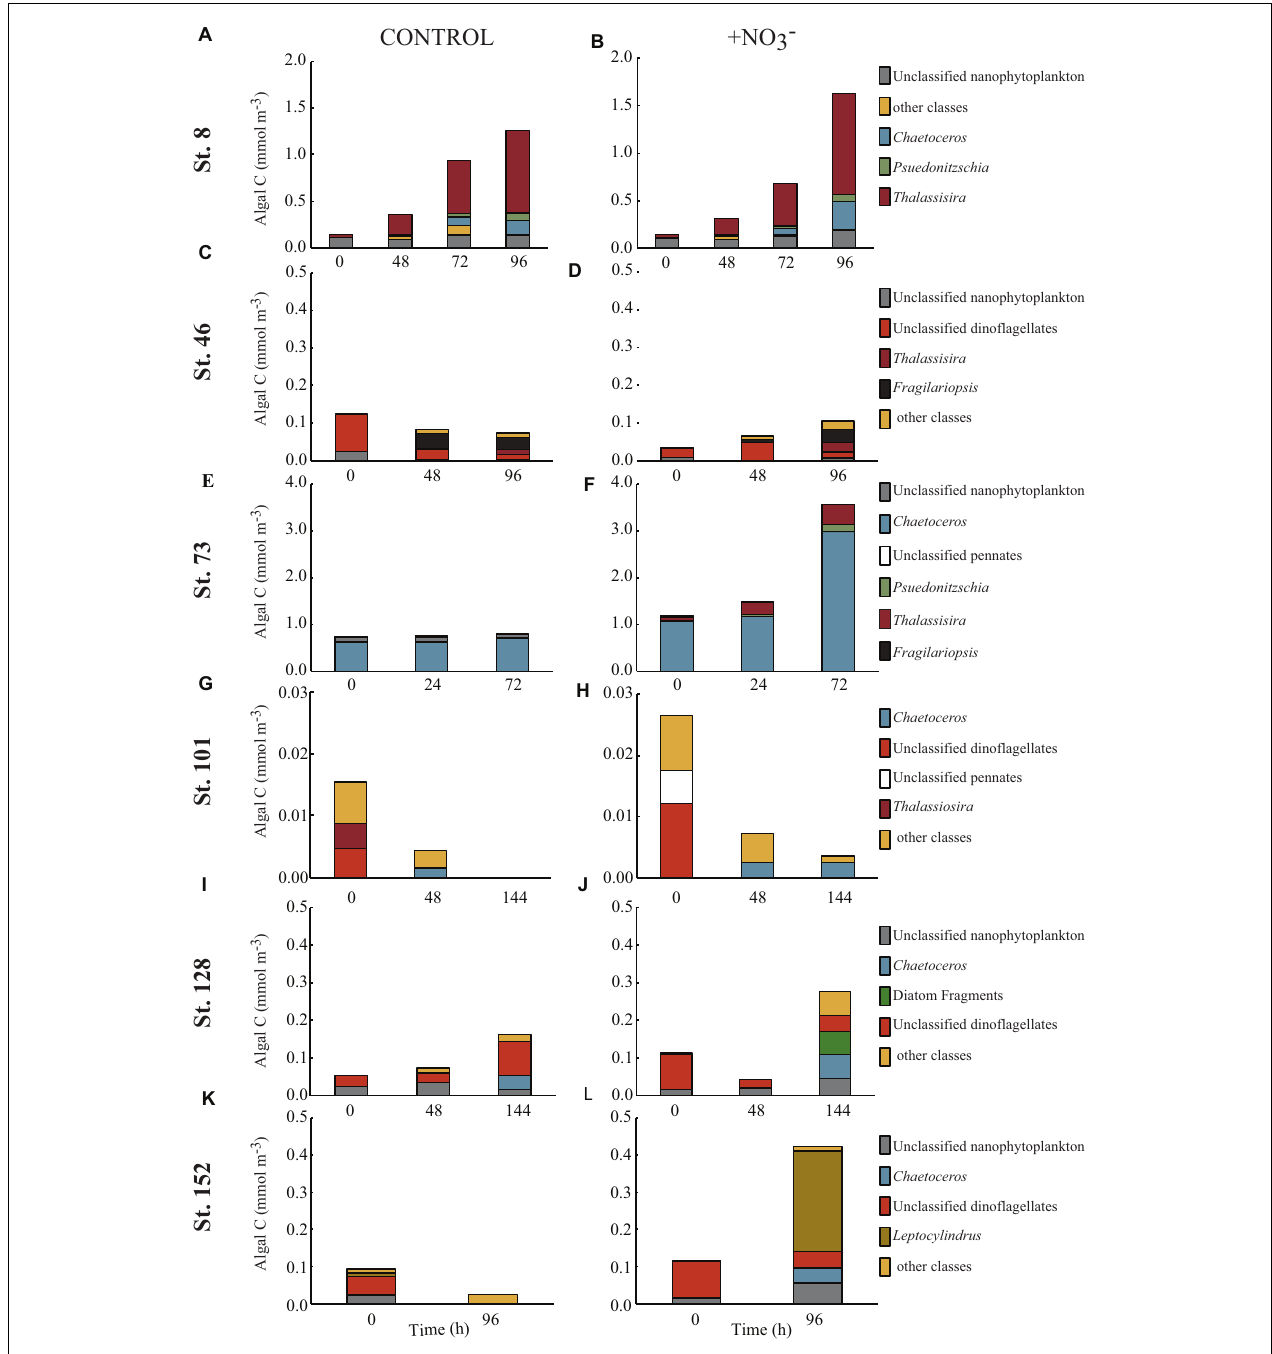
FIGURE 4 | Concentration of phytoplankton biomass (mmol C m − 3 ) found in the top 5–6 contributing taxonomic classes in the control (A,C,E,G,I,K) and nutrient amended (B,D,F,H,J,L) treatments.